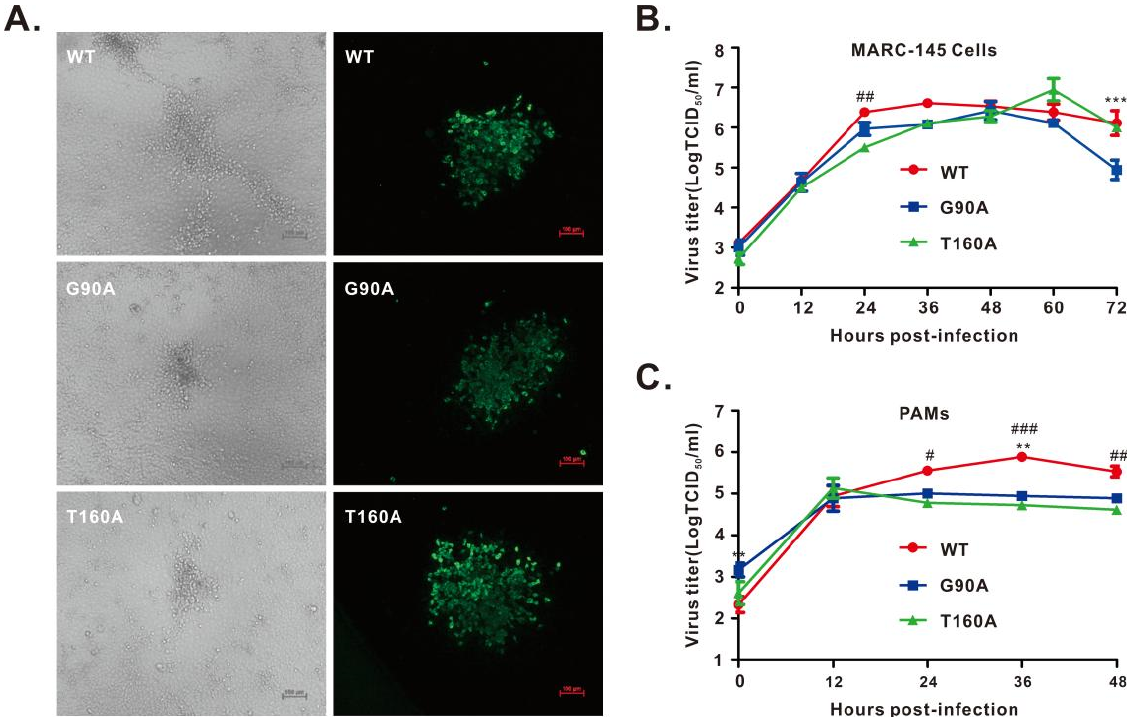
Figure 3. Growth kinetics of the rescued viruses. ( A ) MARC-145 cells were infected with indicated viruses at an MOI of 0.1 for 48 h. The left panel shows virus-induced CPE, and the right panel shows the IFA staining of virus-infected cells with an antibody to PRRSV N protein. The representative images were taken by an inverted Nikon microscope. ( B , C ) Growth kinetics of the rescued viruses in MARC-145 cells ( B ) and PAMs ( C ) at an MOI of 0.1. The total viruses were titrated in MARC-145 cells by an endpoint dilution assay. Asterisks indicate a significant difference in the virus titers between WT and G90A (** p < 0.01; *** p < 0.001). Pound symbols (#) represent a significant difference in the virus titers between WT and T160A (# p < 0.05; ## p < 0.01; ### p < 0.001). The data are shown as the mean ± SD of three independent experiments.